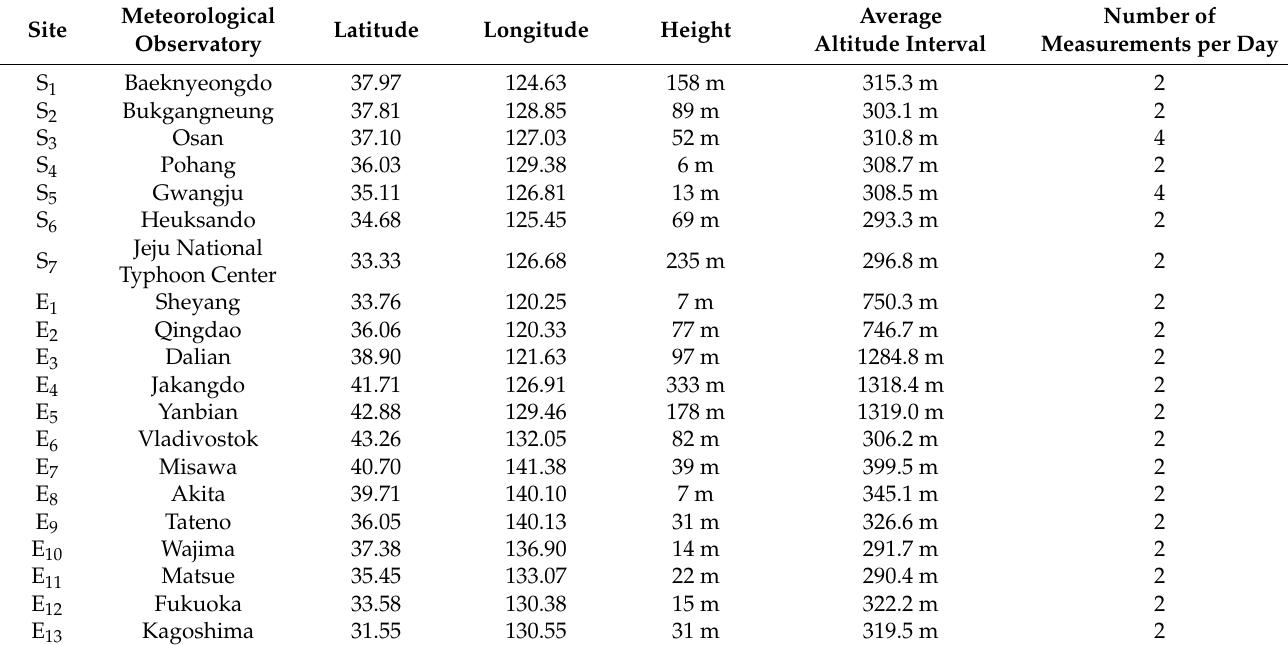
Table 1. Geographical coordinates of the weather stations with measurement